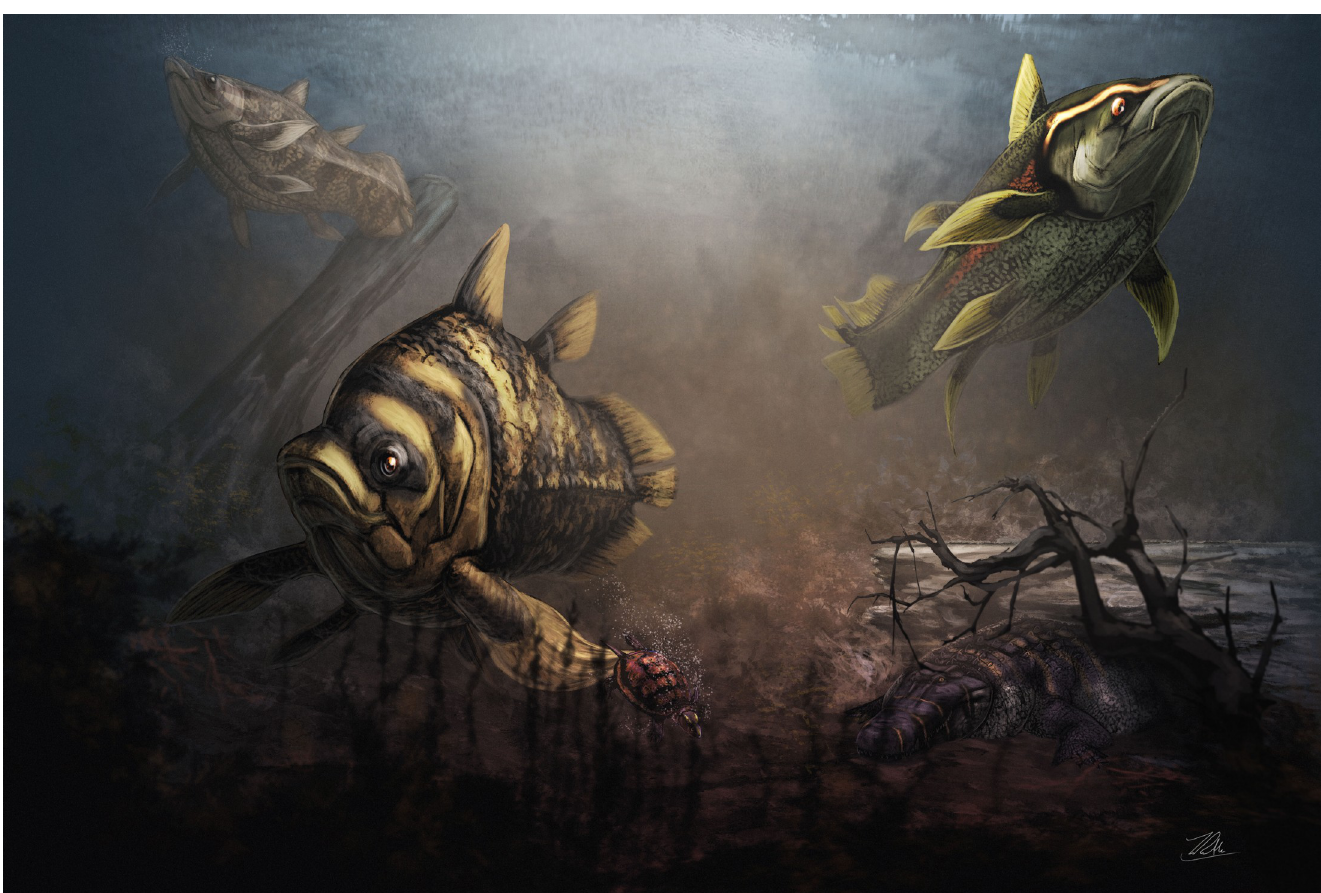
Fig 9. Reconstruction of Mawsonia sp. roaming in the brackish or fresh water costal environment of Texas during the Cenomanian. Original artwork by Zubin Erik Dutta.